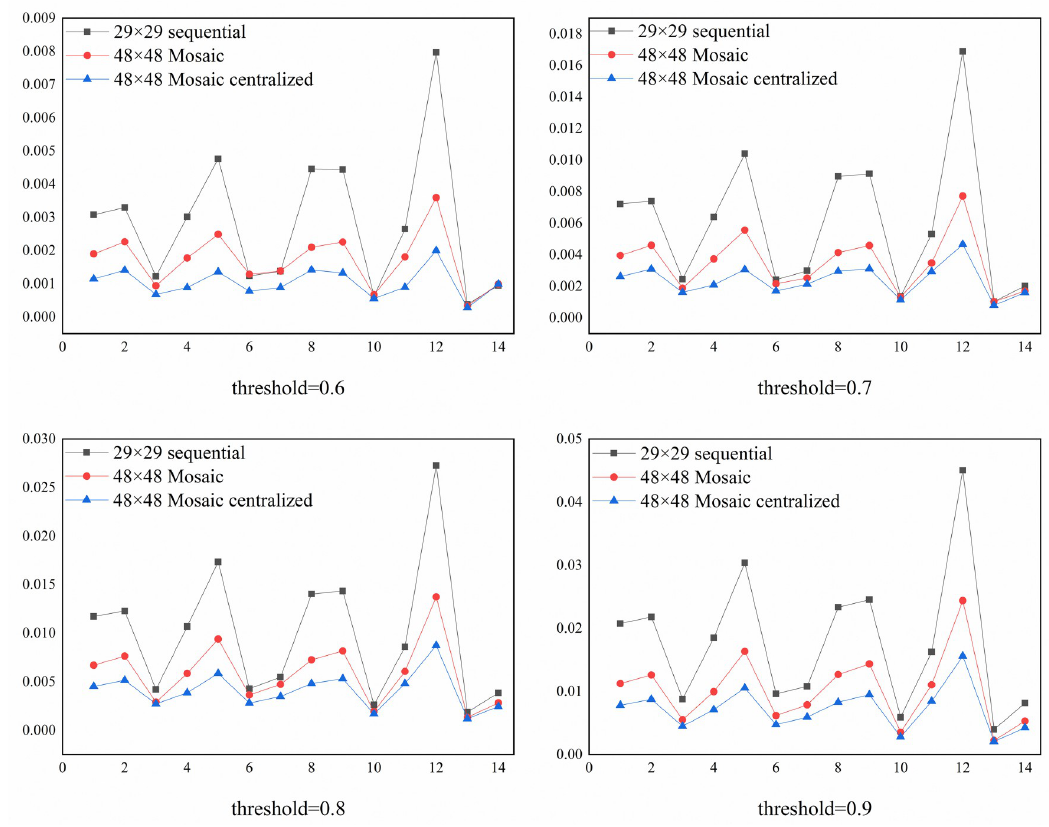
Fig 13. Comparison of UR for the 29-bit CAN ID under different